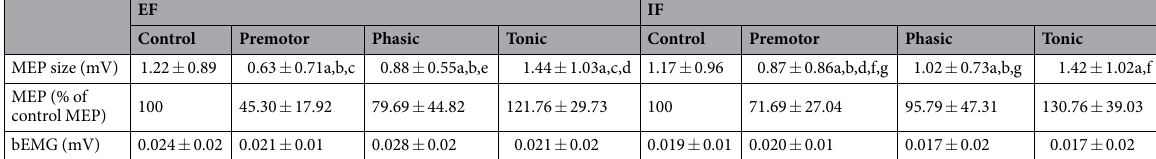
Table 1. Single-pulse TMS in surrounding muscle APB for all four phases of the movement and the two conditions Shown are mean values and SD ( n = 12) for single-pulse MEP size, MEP size related to control MEP expressed in percent and the background EMG (bEMG) for both conditions (EF and IF) in the surrounding muscle APB. Main effect of phase: significant difference ( P < 0.05) for this phase in both conditions compared with the control phase (a) and compared with the tonic phase (b). Interaction effect focus x phase: significant difference ( P < 0.05) for this phase compared to control (c), premotor (d), tonic phase (e) in the EF condition and compared to control (f) and tonic phase (g) in the IF condition. EF = external focus, IF = internal focus of attention.